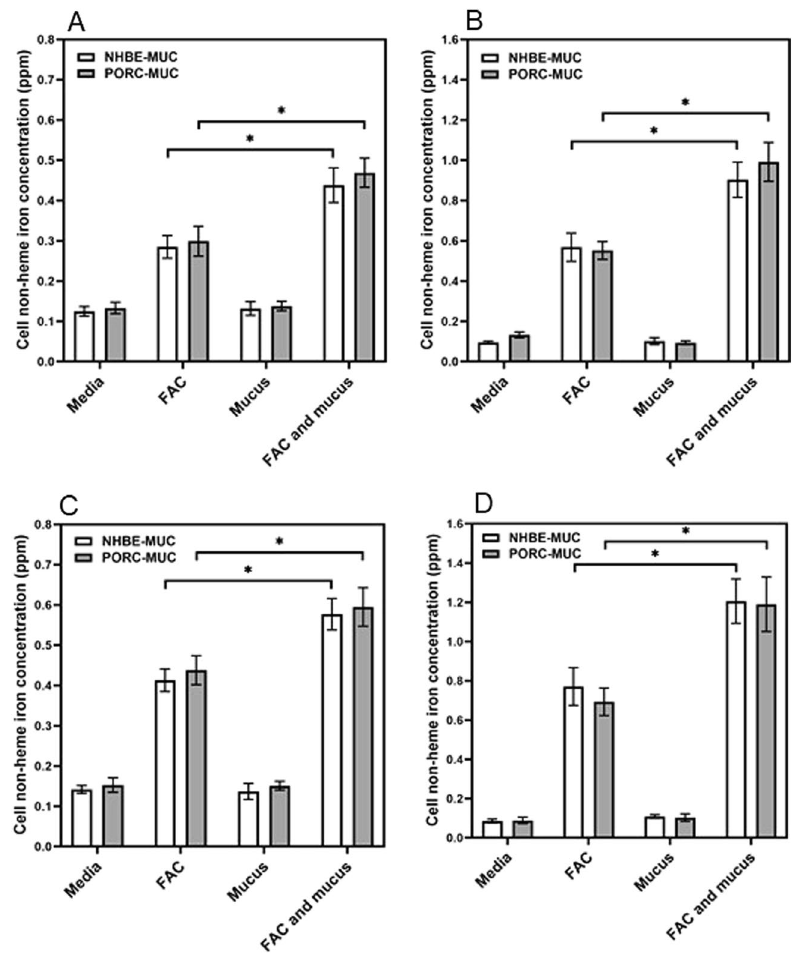
Figure 4. Cell iron concentrations after exposures to mucus and iron. With FAC exposure, cells imported iron. With inclusion of either NHBE-MUC or PORC-MUC, concentrations of iron in BEAS-2B cells significantly increased at both 4 and 24 h ( A , B respectively) to levels greater than those observed with FAC alone. Similarly, THP1 cells imported significantly greater concentrations of FAC at 4 and 24 h ( C , D respectively) with inclusion of either NHBE-MUC or PORC-MUC relative to metal alone. Separate one way ANOVAs were employed for NHBE-MUC and PORC-MUC. *Increased relative to FAC (p <